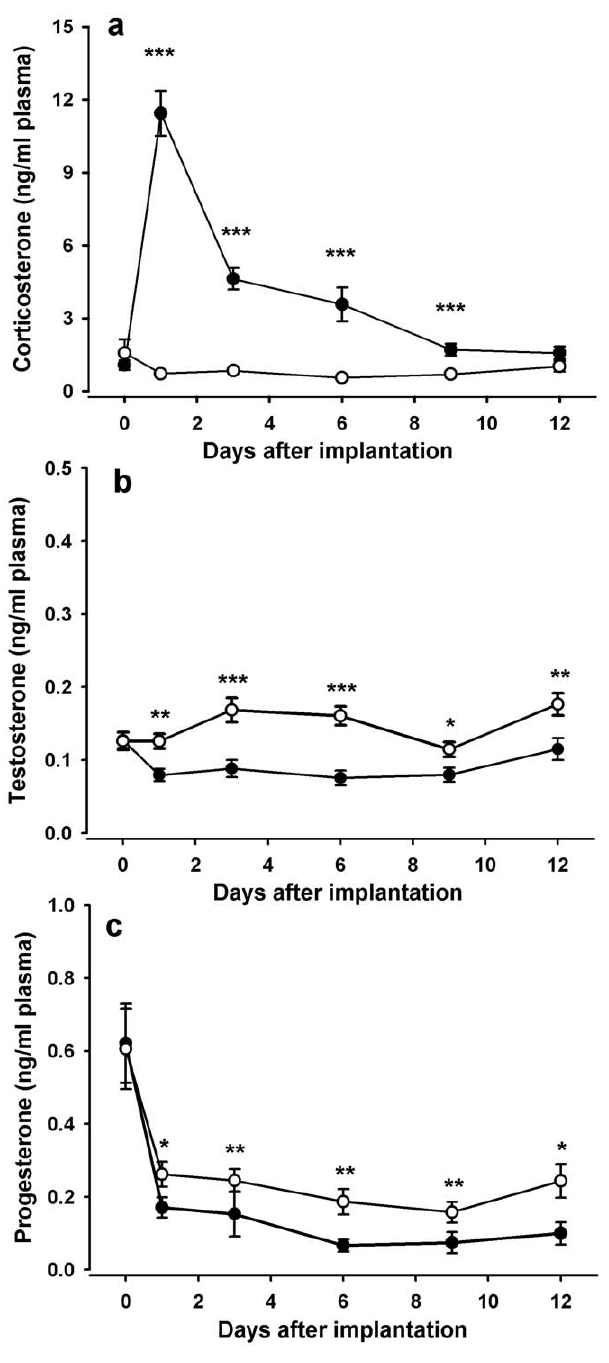
Figure 2. Hormone concentrations in plasma after pellet implantation. Mean ( 6 SE) concentrations of corticosterone (a), N testosterone (b), progesterone (c) in plasma of hens implanted with ) or placebo ( # ) pellets. Asterisks indicate significant corticosterone ( differences between treatments on individual days ( *** p # 0.001; ** p # 0.01; * p # 0.05; t-tests).